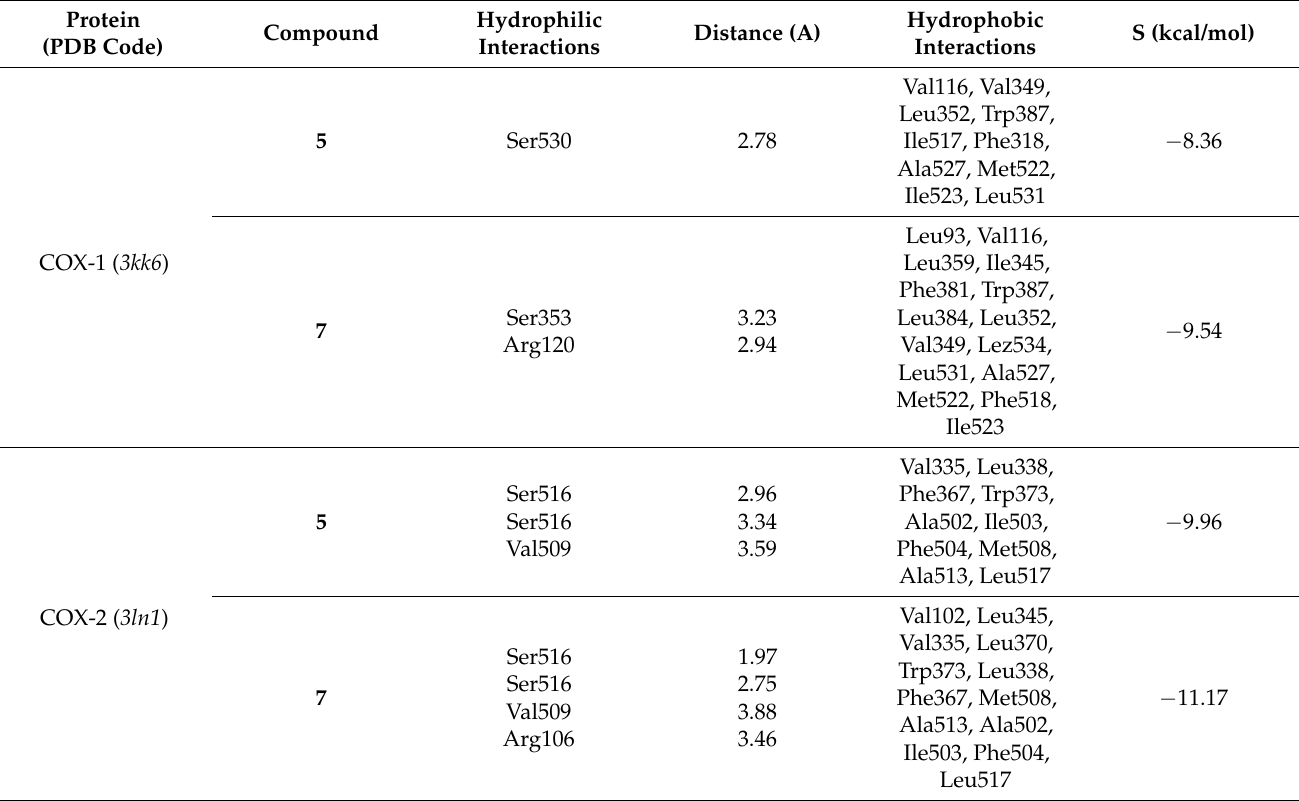
Table 1. Binding affinity scores and interactions of compounds 5 and 7 into the binding cavity